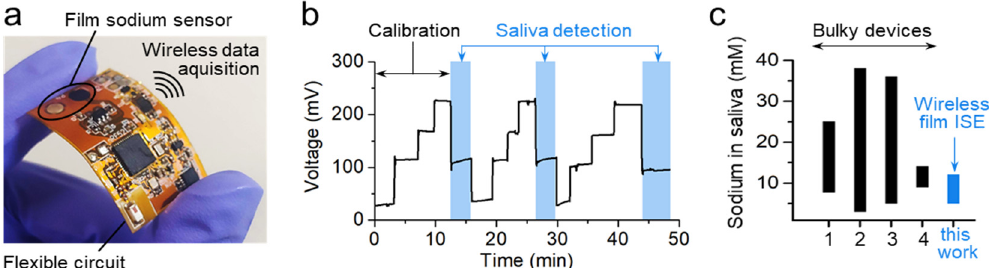
Figure 1. Wireless, flexible sodium ion-selective-electrode (ISE) system. ( a ) Photograph of wireless, flexible electronic system with all-solid-state ISE and reference electrode (RE). ( b ) Repeated measurements of signal voltages in calibration sodium solutions (concentrations: 10 − 4 , 10 − 2 , 10 − 1 , and 1 M) and human saliva. ( c ) Comparison of measured sodium levels between commercial bulky devices (1–4) and our wireless system, where reference 1: 8.7–24 mM (generally known) [36], reference